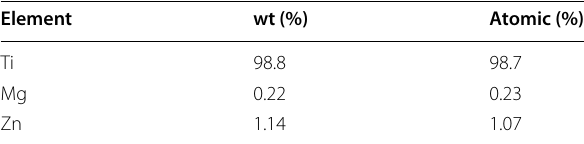
Table 5 XRF analysis of Zn/Mg co-doped TiO concentration in ZMT4 Element